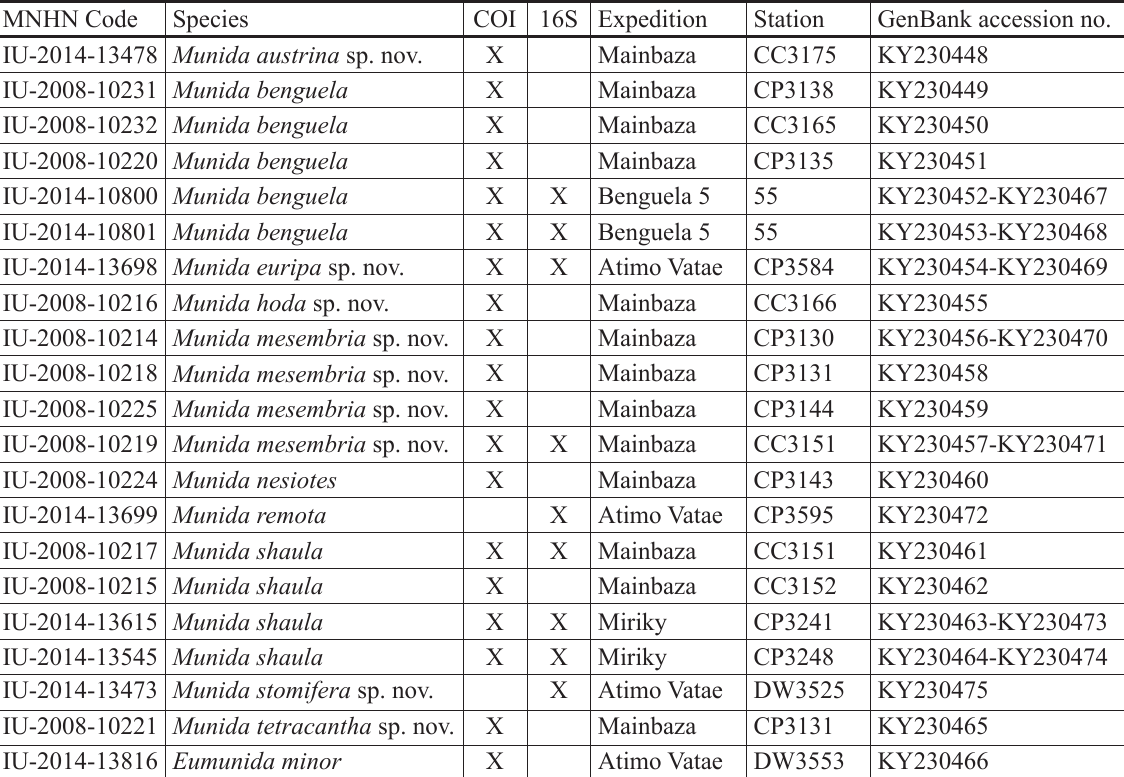
Table 1 . Specimens studied for mitochondrial DNA sequences (COI and 16S), including MNHN registration codes, expedition, station, and GenBank accession